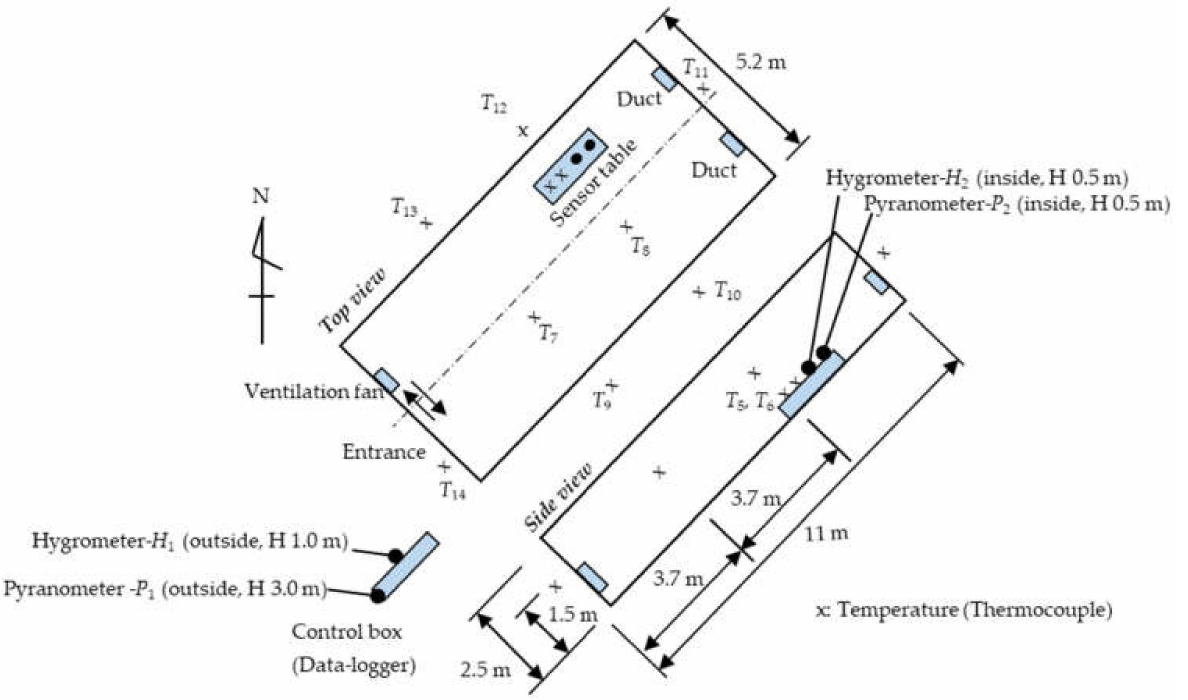
Figure 3. Greenhouse layout and measurement